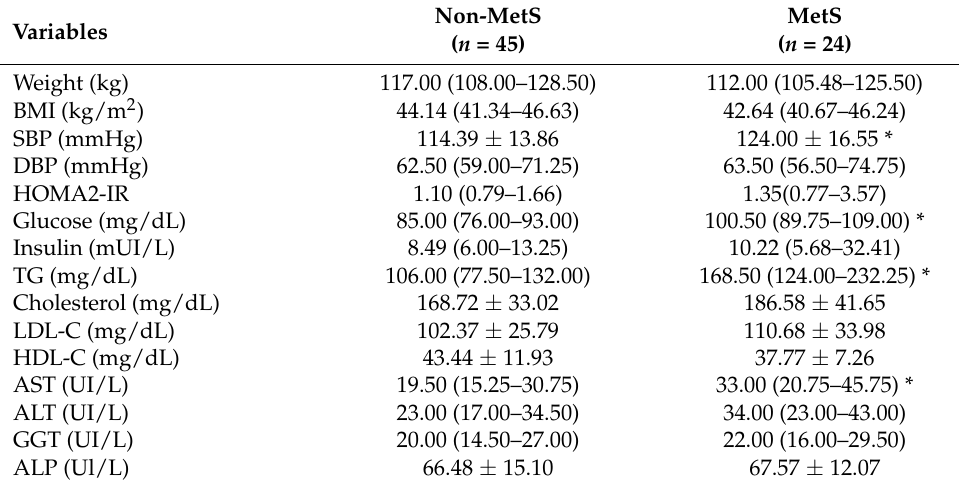
Table 1. Clinical and biochemical variables of women classified according to the presence or absence of metabolic syndrome.